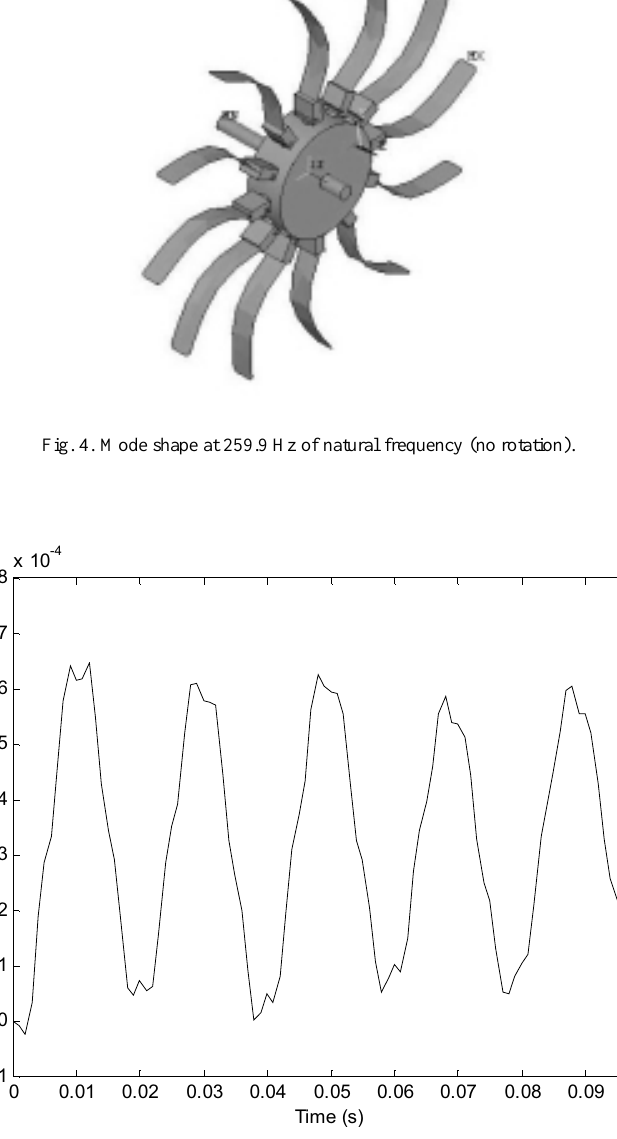
Fig. 5. PZT sensor voltage for the non-rotating system. An upward step force is acting at the tip of the blade where PZT sensor is